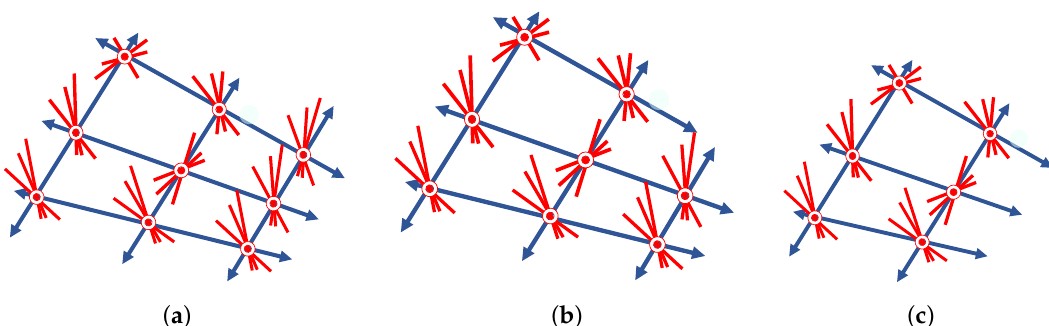
Figure 56. Three lines meeting three lines in nine points of intersection form a projectively special position ( a ) on a quadric surface which is known to be flexible. Releasing the last intersection to make the lines more generic ( b ) yields a structure that is infinitesimally rigid. Figure ( c ) counts to be infinitesimally